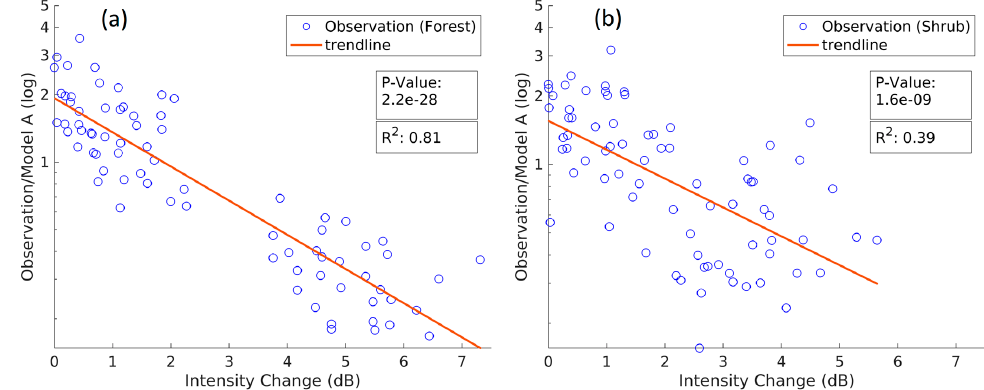
Figure 3. Semi-logarithmic scatter plot of coherence ratio, i.e., observation/model A, versus the relative intensity changes for forested ( a ) and shrub ( b ) land cover types.